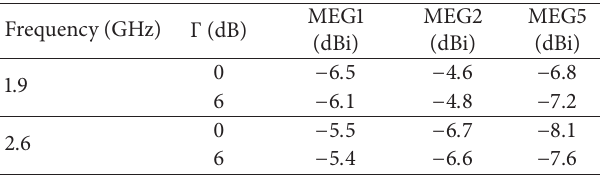
Table 3: Mean effective gains of the antennas.